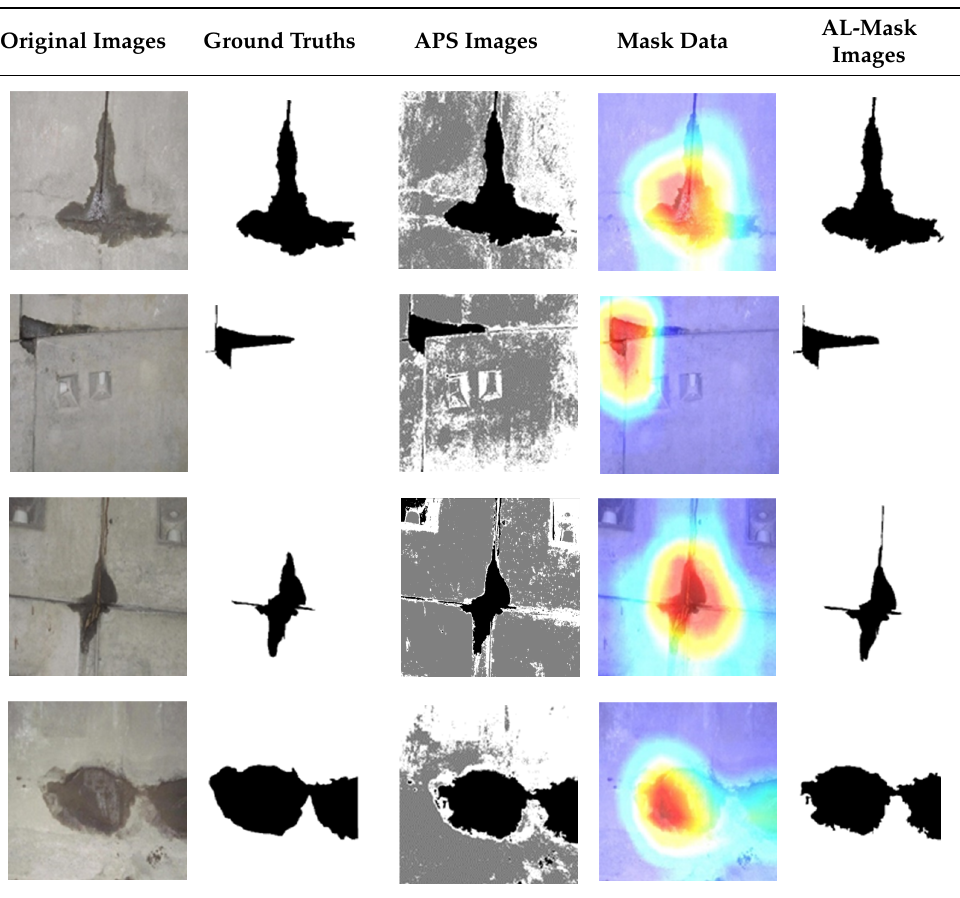
Table 5. Comparison of the manually labeled dataset and the automatically labeled dataset.